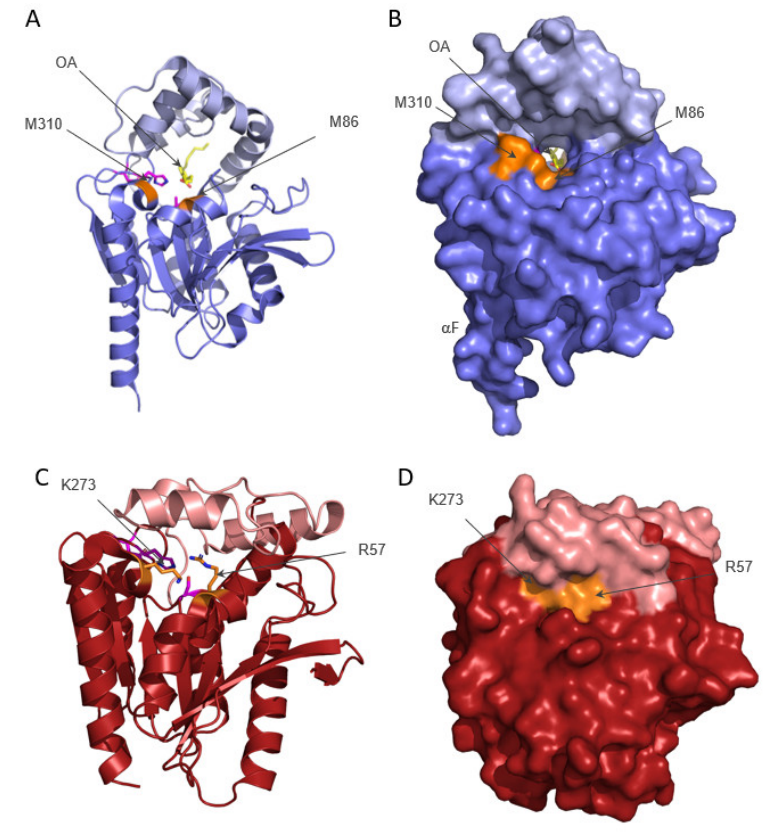
Figure 2. Comparison of the experimental structures of ABHD6 and MGL. ( A ) ABHD6 is complexed with oleic acid (OA, depicted in yellow). The cap/lid region is colored light blue and the core is slate-blue. The active site residues (please note the S148A exchange) are depicted as magenta sticks. ( B ) Surface representation of ( A ). The tunnel is visible and spans through the entire molecule, the rim residues M86 and M310 (orange) are on one face of the molecule, and R256 is located on the other side. ( A , B ) These images correspond to an approximately 180° rotation to the left of Figure 1B with αF on the left. ( C , D ) Cartoon ( C ) and surface ( D ) representation of human MGL (P20-A297, PDB code 3HJU). Human MGL was aligned to human ABHD6 and presented in the same orientation as ABHD6 in panels 2A and 2B. Residues R57 and K273 are at equivalent spatial positions to K86 and M310 in ABHD6 and are indicated in orange. The lid of human MGL is shown in salmon and the core in dark red. Catalytic residues S122, D239, and H269 are colored magenta.